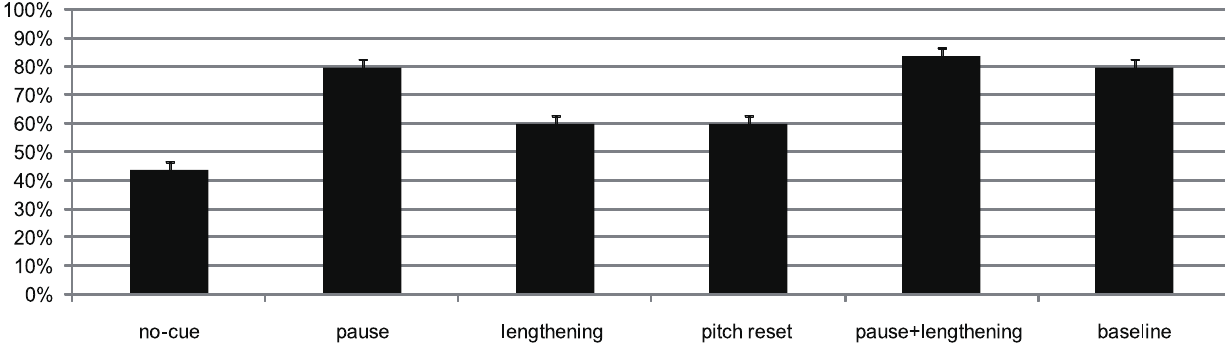
Figure 3. Proportions of the boundaries detected with naturalness rating as covariate.